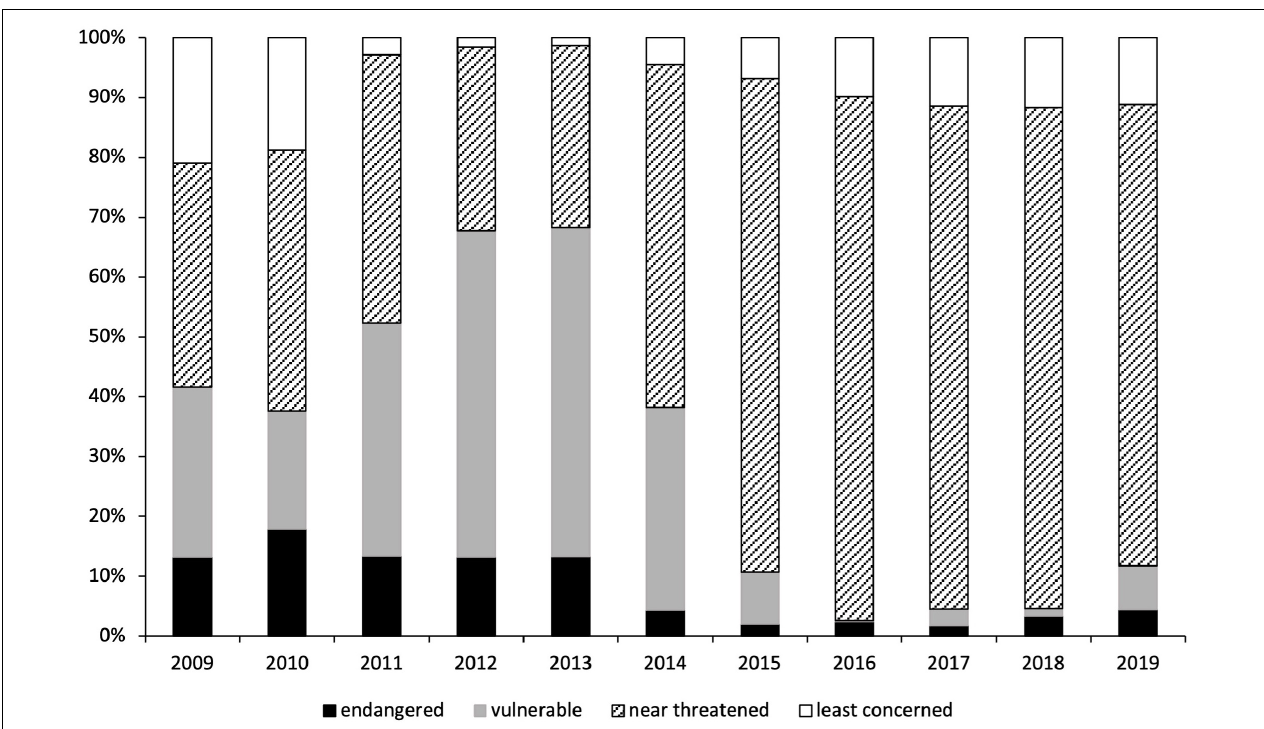
FIGURE 2 | Annual elasmobranch landings in Sesimbra fishing port of each IUCN Red List Conservation Status Classification, shown as percentages.